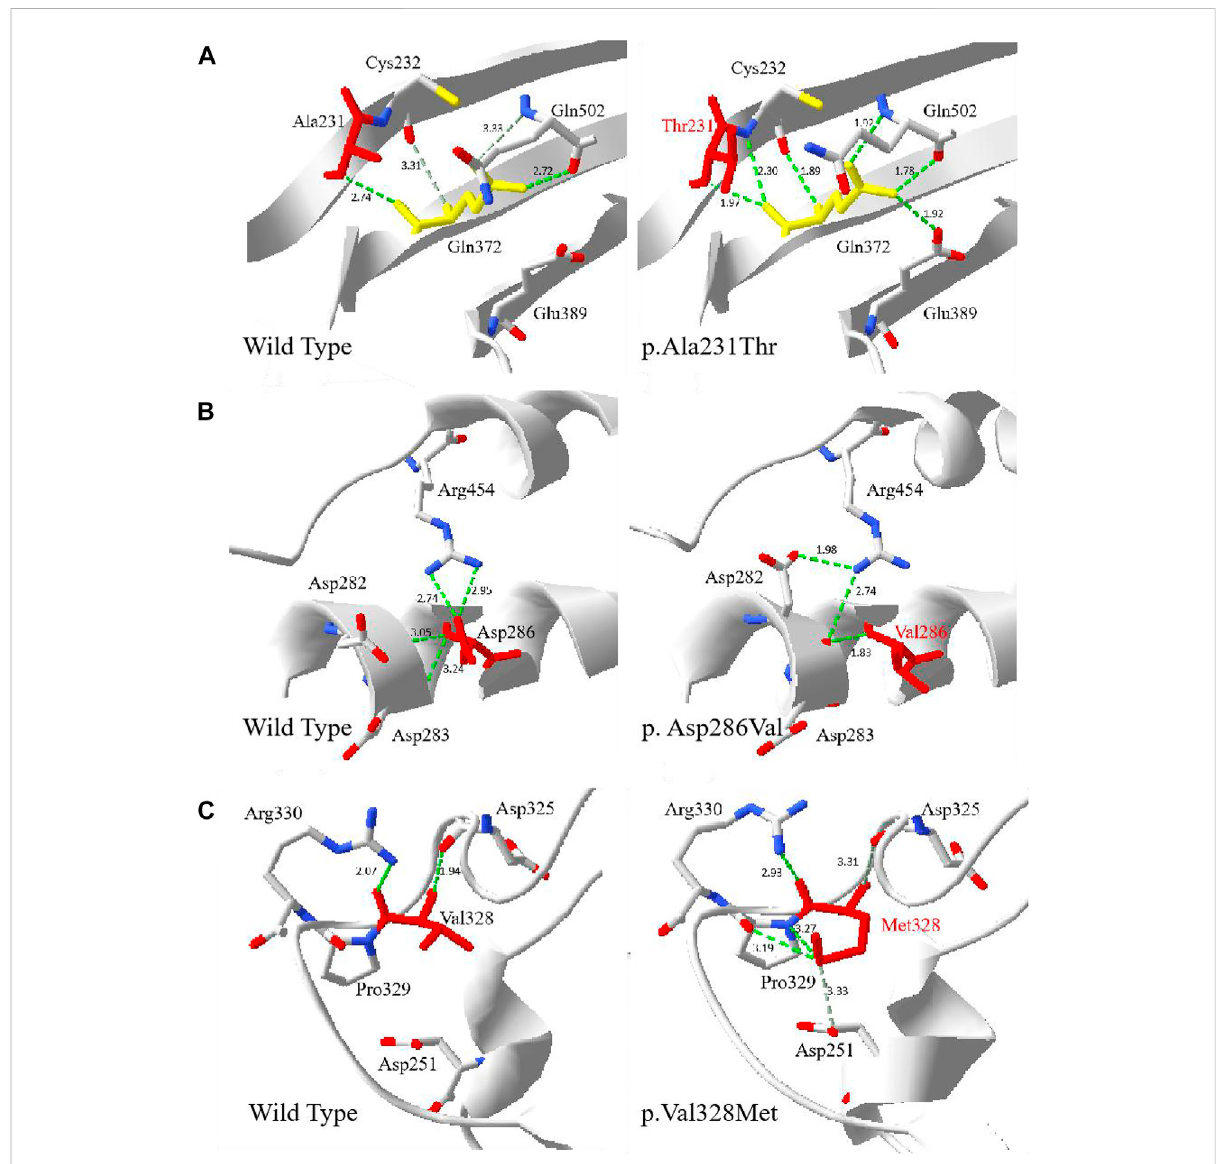
FIGURE 2 The 3D evaluation of the G6PD variants protein. The crystal structure of the human G6PD was obtained from PDB (PDI id: 2BH9 and 2BHL) . Green dot lines represent hydrogen bonds. Grey dot lines represent weak hydrogen bonds. The atoms of amino acids were colored by type (carbon was grey, oxygen was red, and nitrogen was blue). (A) The wild type and p.Ala231Thr G6PD. The residue Thr231 was shown in red. (B) The wild type and p. Asp286Val G6PD. The residue Val286 was shown in red. (C) The wild type and p.Val328Met. The residue Met 328 was shown in